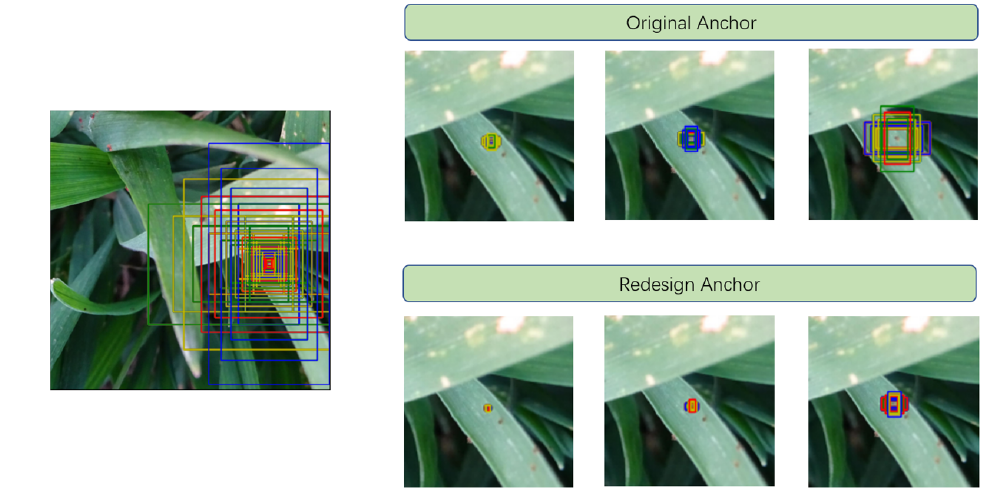
Figure 6. Original Anchor vs. optimally designed Anchor: the above are the original three Anchor modules with the smallest scale; the below are the three Anchor modules with the smallest scale after